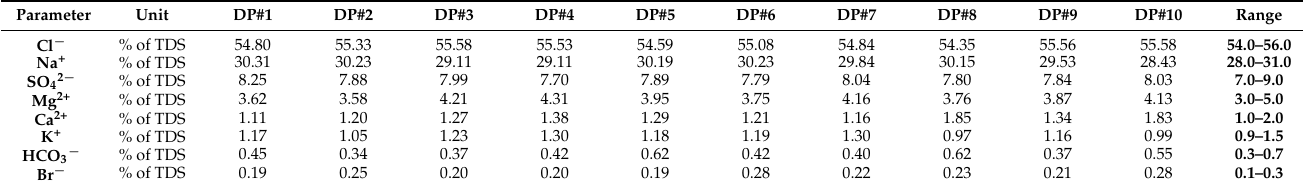
Table 5. Major ions in brine (as a percentage of total dissolved solids—TDS) per desalination plant (DP#) and global range per parameter.